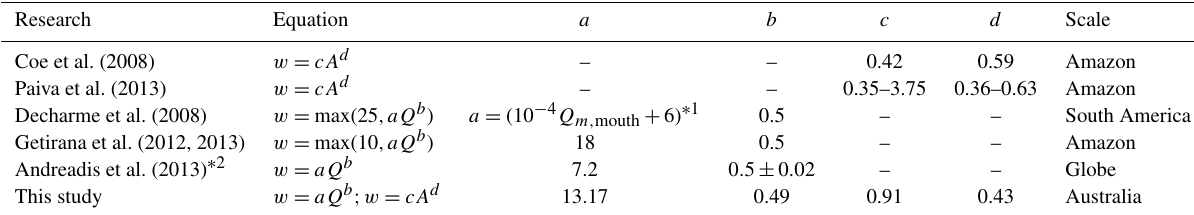
Table 5. Comparison of coefficients and exponents for Eqs. (1) and (2) between different studies.